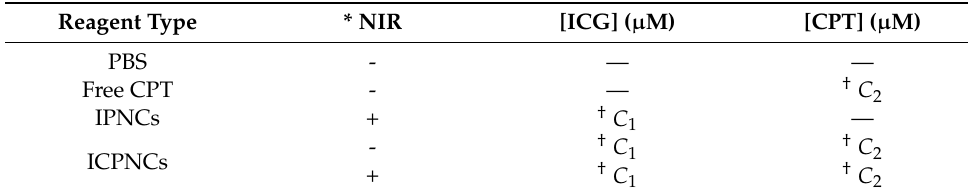
Table 2. Experimental setting for the in vivo anticancer